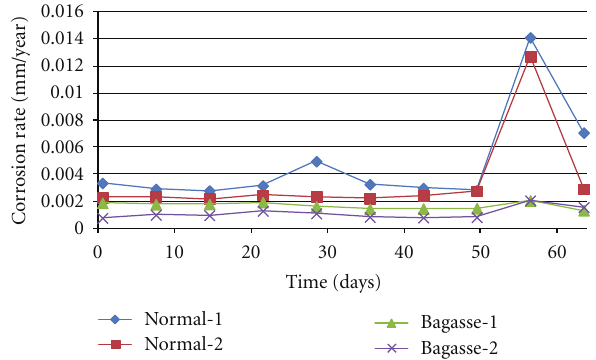
Figure 4: Corrosion potential of specimens.